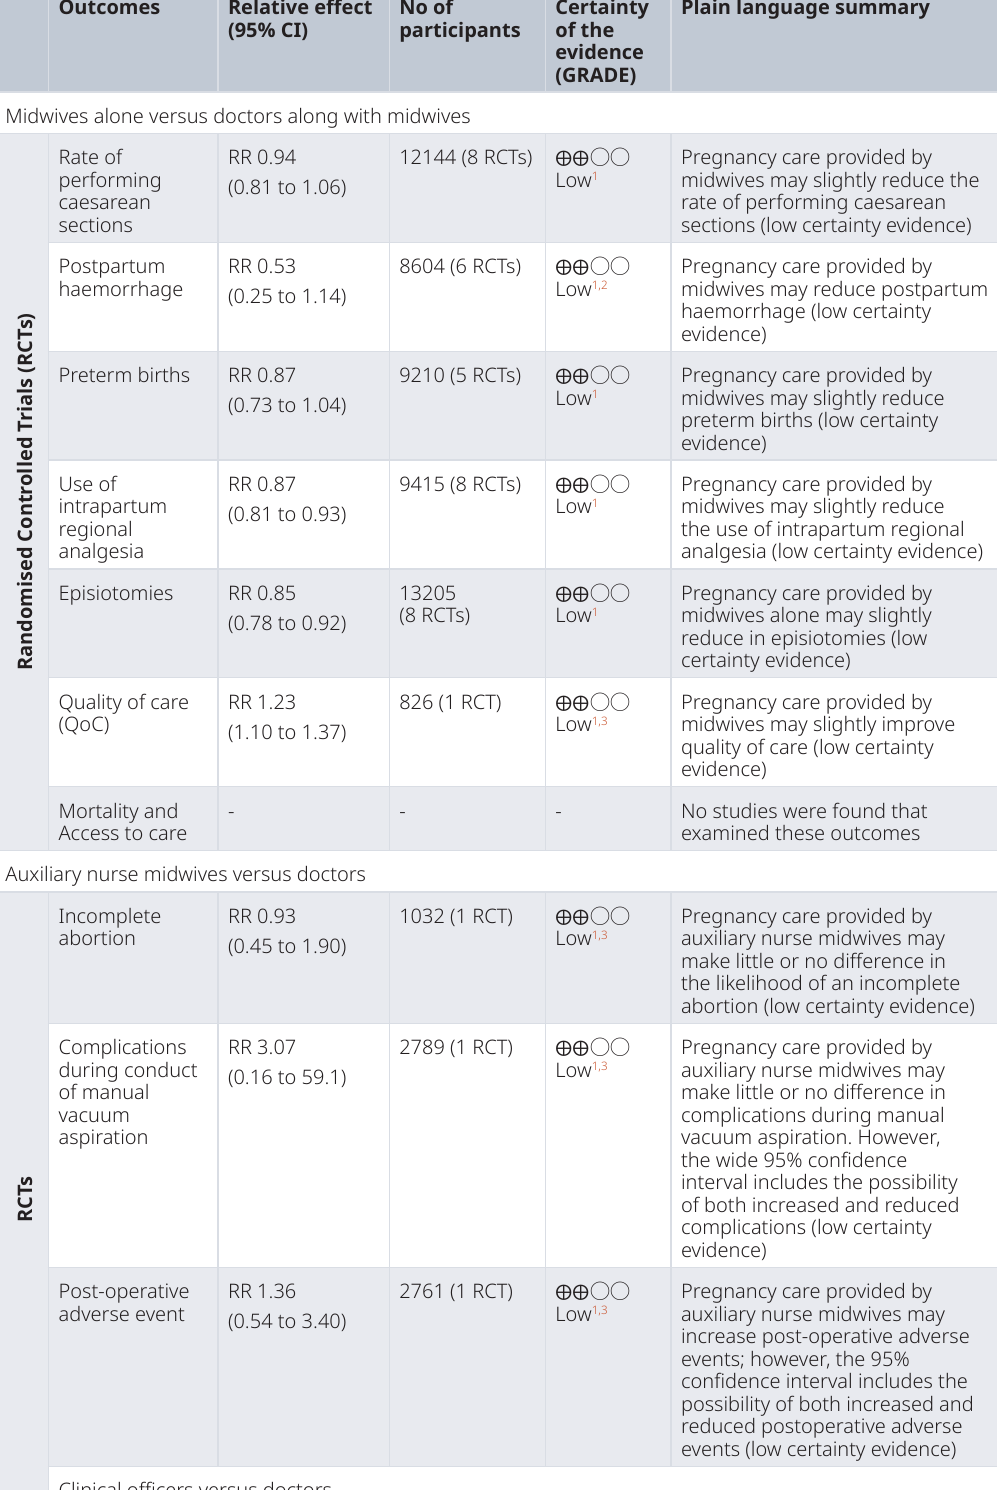
Table 1. Summary of findings for care provided by MLHPs for pregnancy and